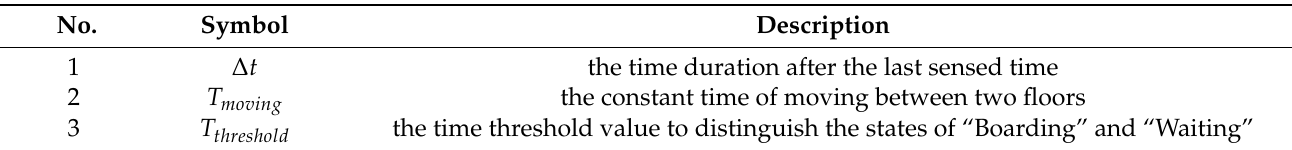
Table 2. Parameters of the FSM model.